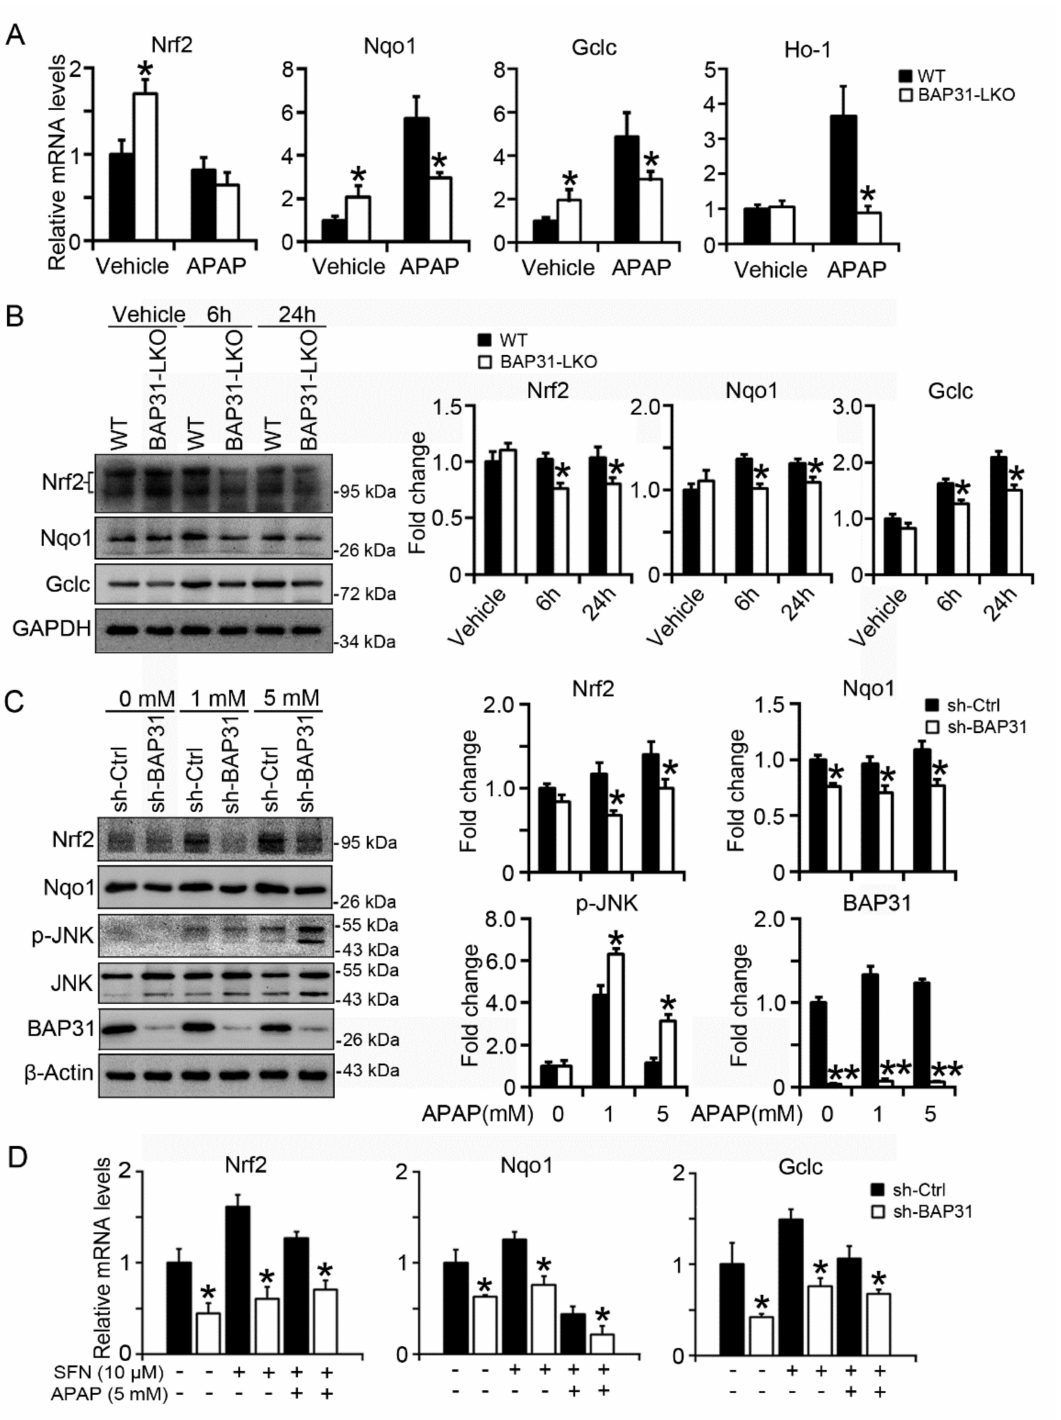
Figure 5. BAP31-deficiency reduced Nrf2 signaling activation. ( A ) The transcriptional levels of Nrf2 , Nqo1 , Gclc , and Ho-1 were measured in WT, and BAP31-LKO mice post APAP administration. The relative mRNA levels were normalized by 18S rRNA levels. n = 5–7 per group. ( B ) The protein levels of Nrf2, Gclc, and Nqo1 were determined. GAPDH was used as